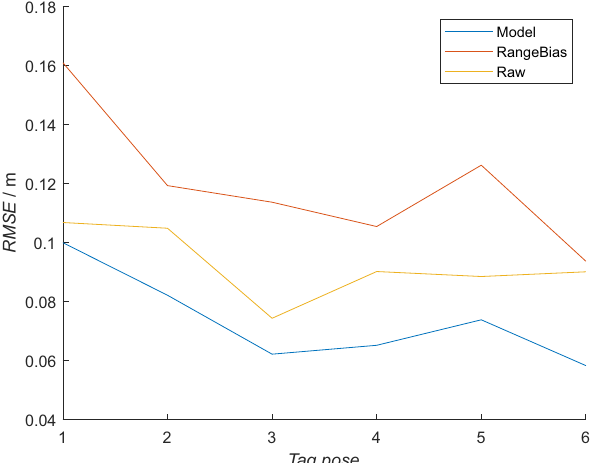
Figure 18. RMSE error for distances to all 12 anchors in the RTLS realistic setup in a laboratory for all six tags’ poses for the presented model (Model), a method that does not include orientational information (Range Bias) and raw measurements